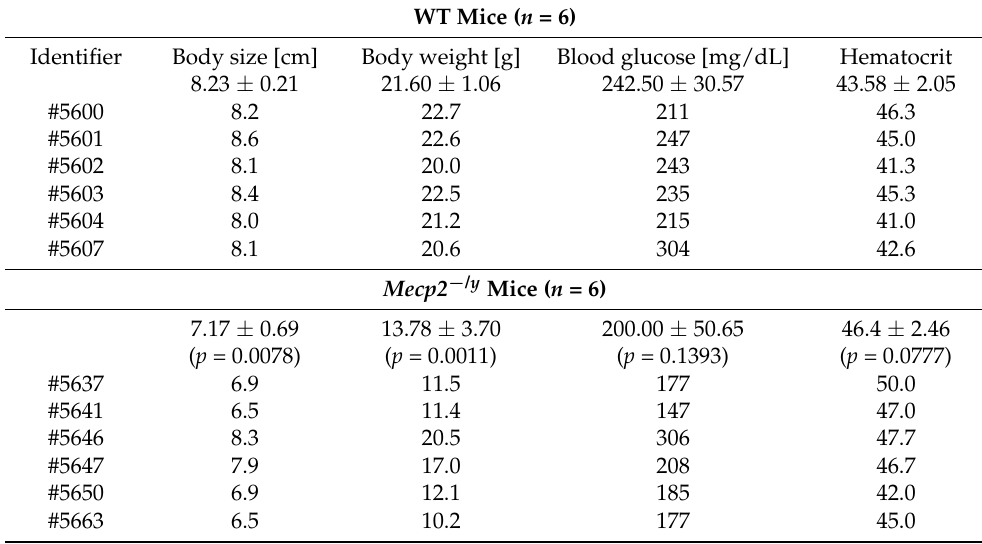
Table 1. Phenotypic features of the analyzed WT and Mecp2 − /y mice, including the respective means ± standard deviations. Genotypic comparison was performed in a two-tailed two-sided unpaired t -test (see p